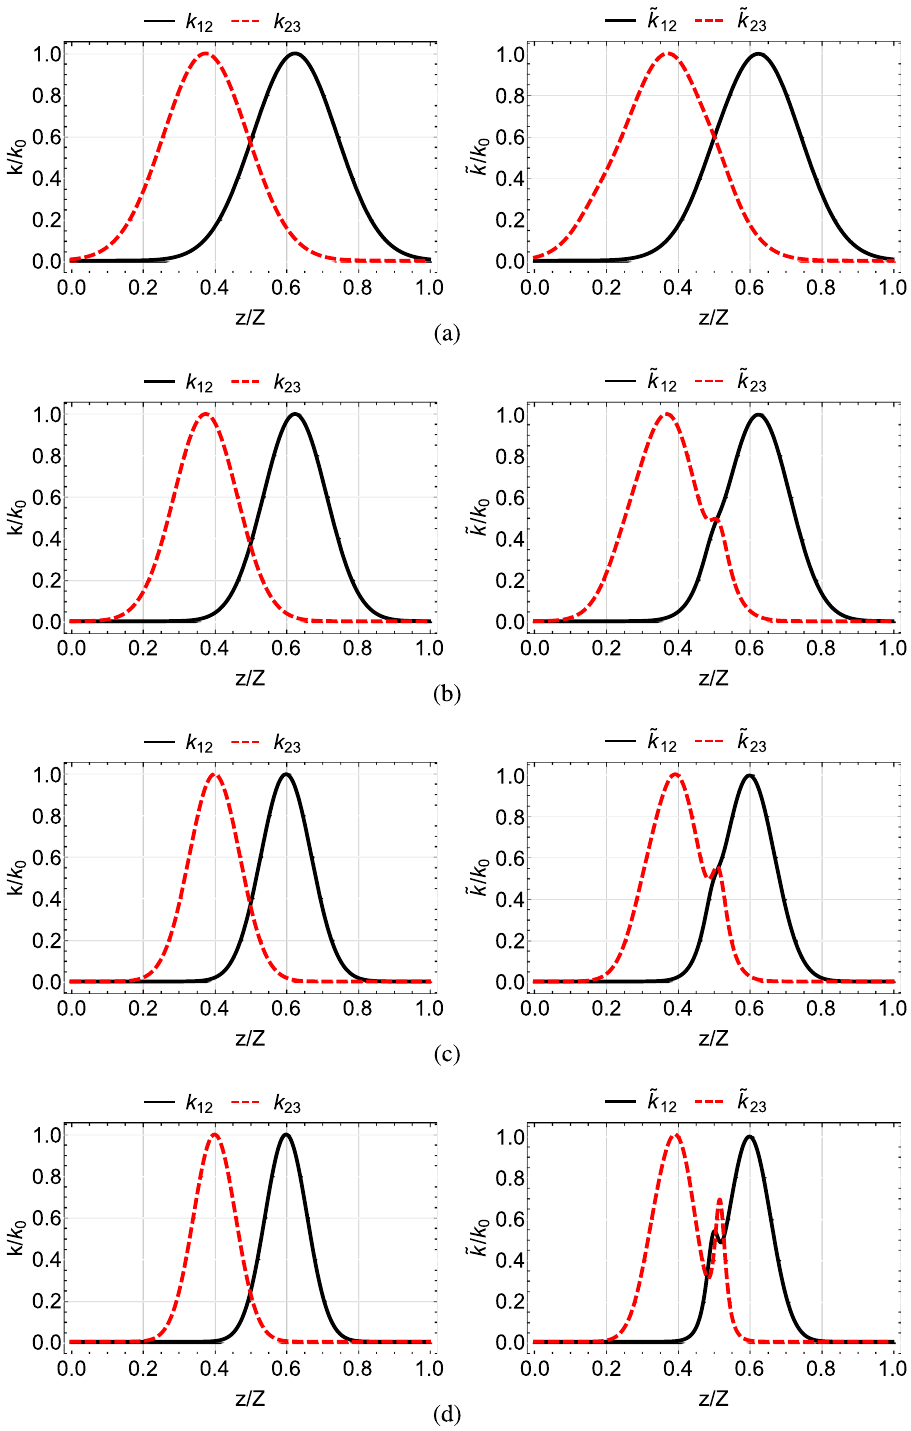
Figure 2. Gaussian (left column) and modified shortcut (right column) coupling coefficients for parameters Z 30 mm, k 0 = Z / 10 , ( d ) τ ζ =